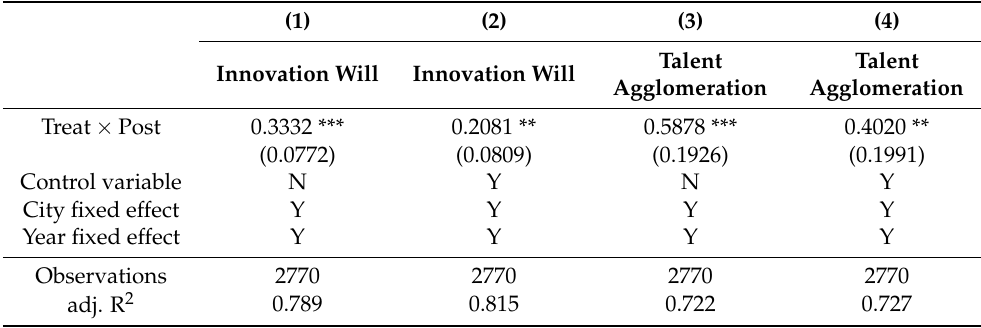
Table 5. Regression results of innovation willingness and talent agglomeration.